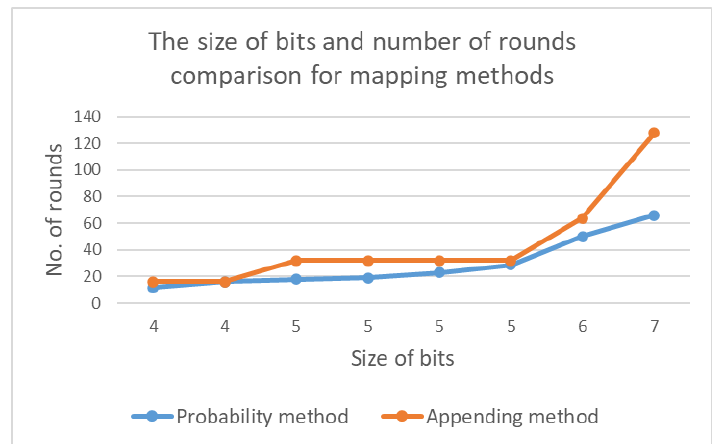
Figure 31. Comparison of number of rounds used in mapping phase method and the size of bits added to x i .